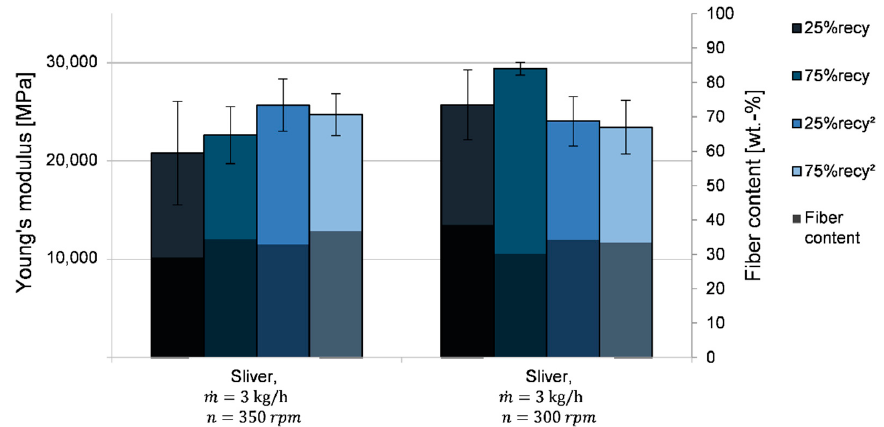
Figure 12. Young’s moduli of specimens produced in the single ‐ stage process with varying recycling content and corresponding fiber content of the matrix.